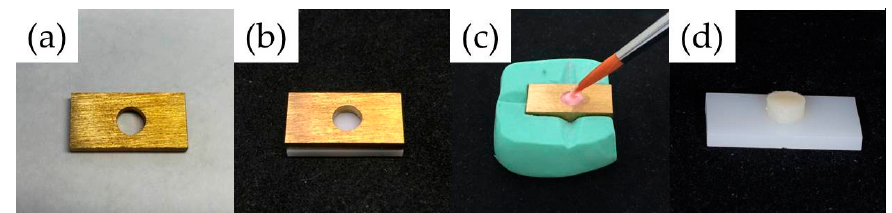
Figure 2. Procedure of porcelain layering: ( a , b ) a brass jig; ( c ) porcelain layering; and ( d ) the specimen after glazing.